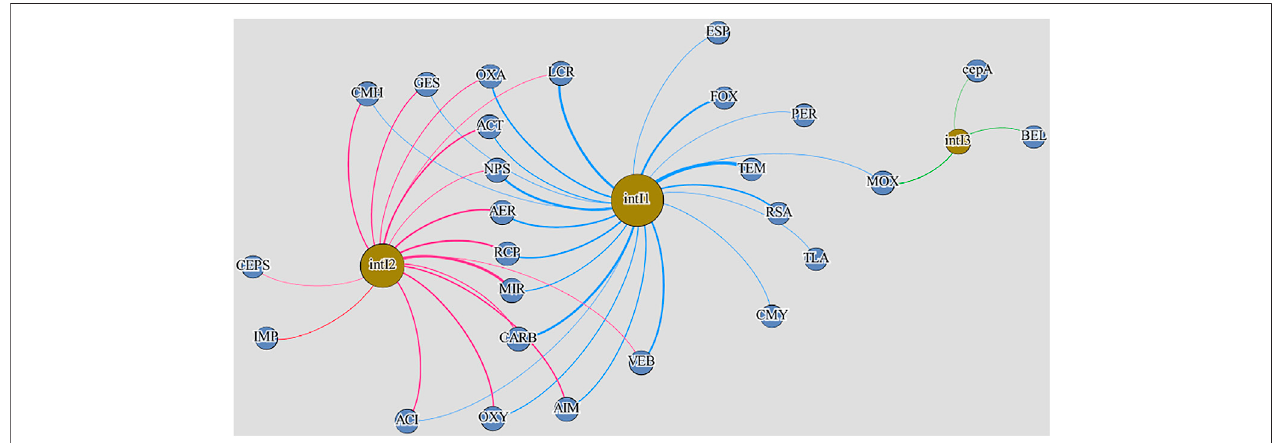
FIGURE3| Networkanalysisofintegraseandbeta-lactamasegenesinsamplesfromS-WWTP.Allcorrelationsinthediagramarestatisticallysigni fi cant( p < 0.01). Edges: blue — intI1:beta-lactamase gene correlations, yellow — intI2:beta-lactamase gene correlations, pink — intI3:beta-lactamase gene correlations; Nodes: yellow — integron integrase genes, blue — beta-lactamase genes. S-WWTP stands for the wastewater treatment plant from the Silesia